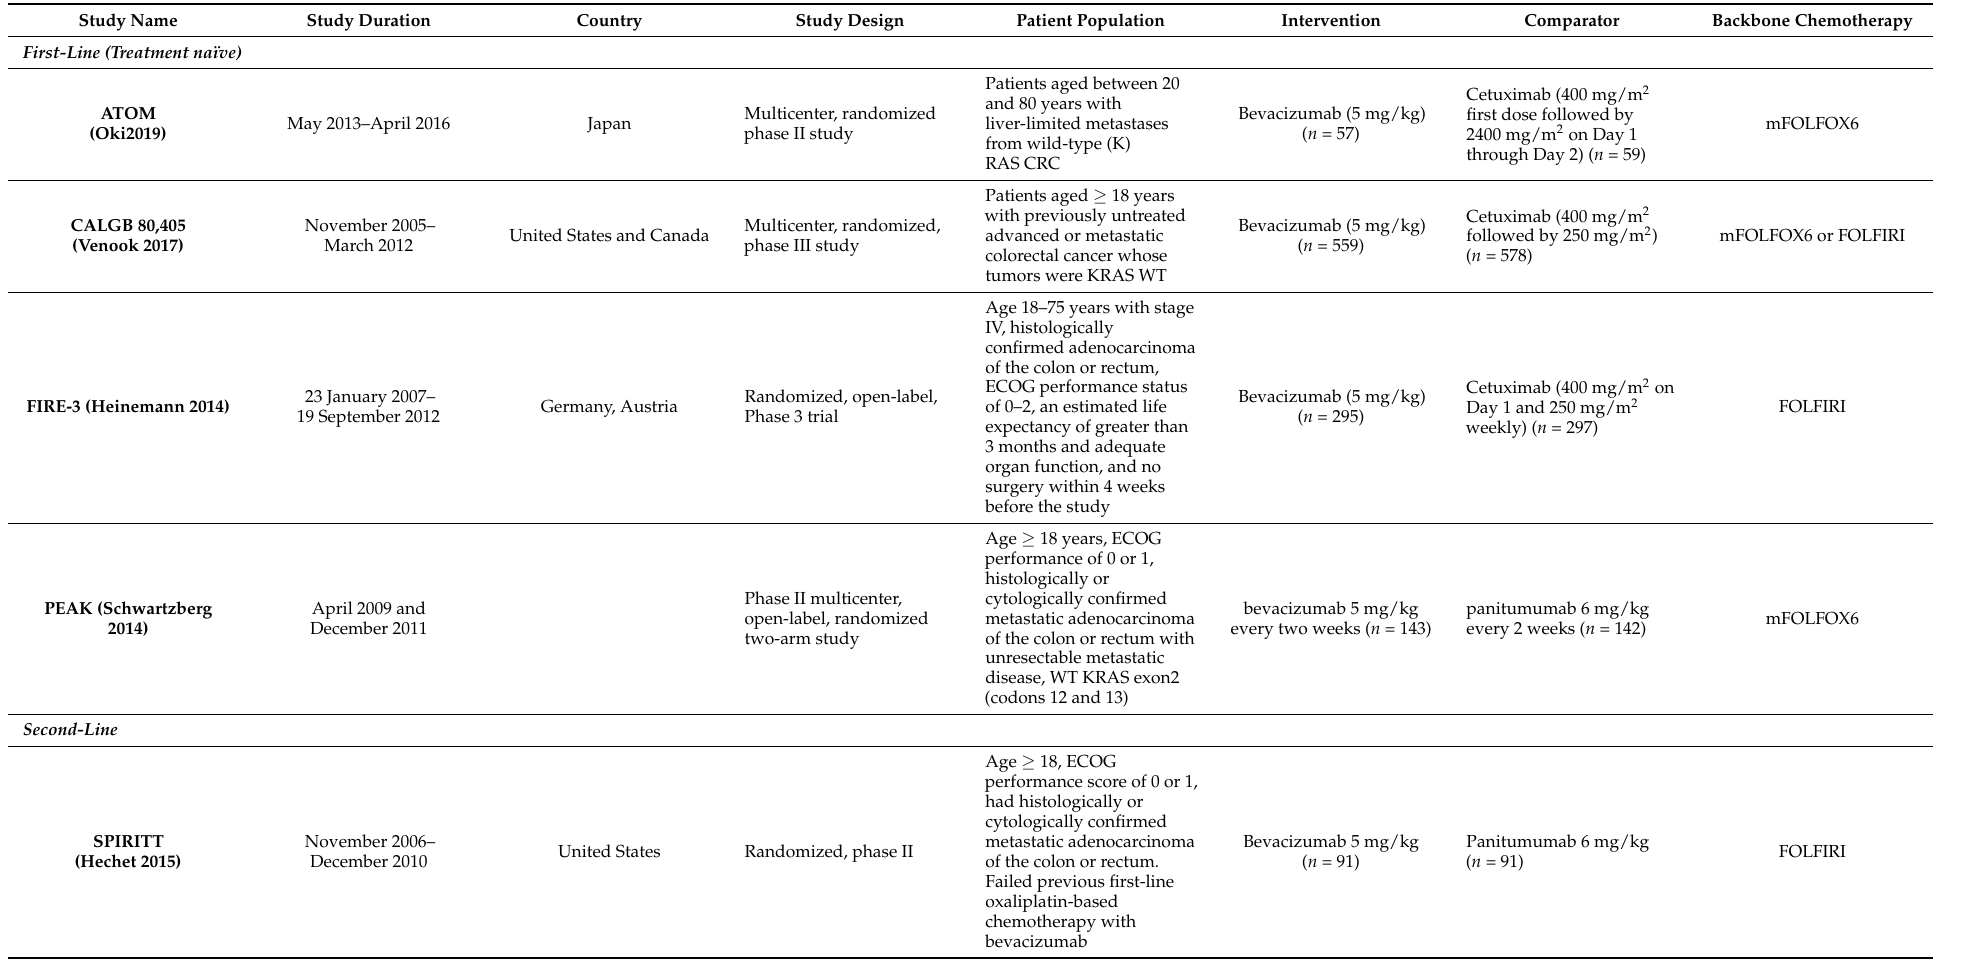
Table 2. Study characteristics of included